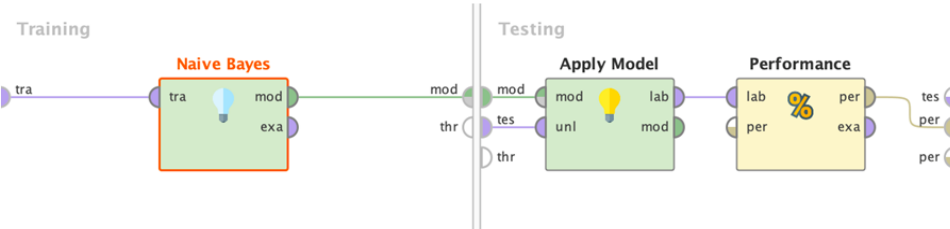
Figure 6. Subprocesses of the Cross Validation operator displaying the training section using Naïve Bayes classifier algorithm and testing sections displaying the model’s performance.